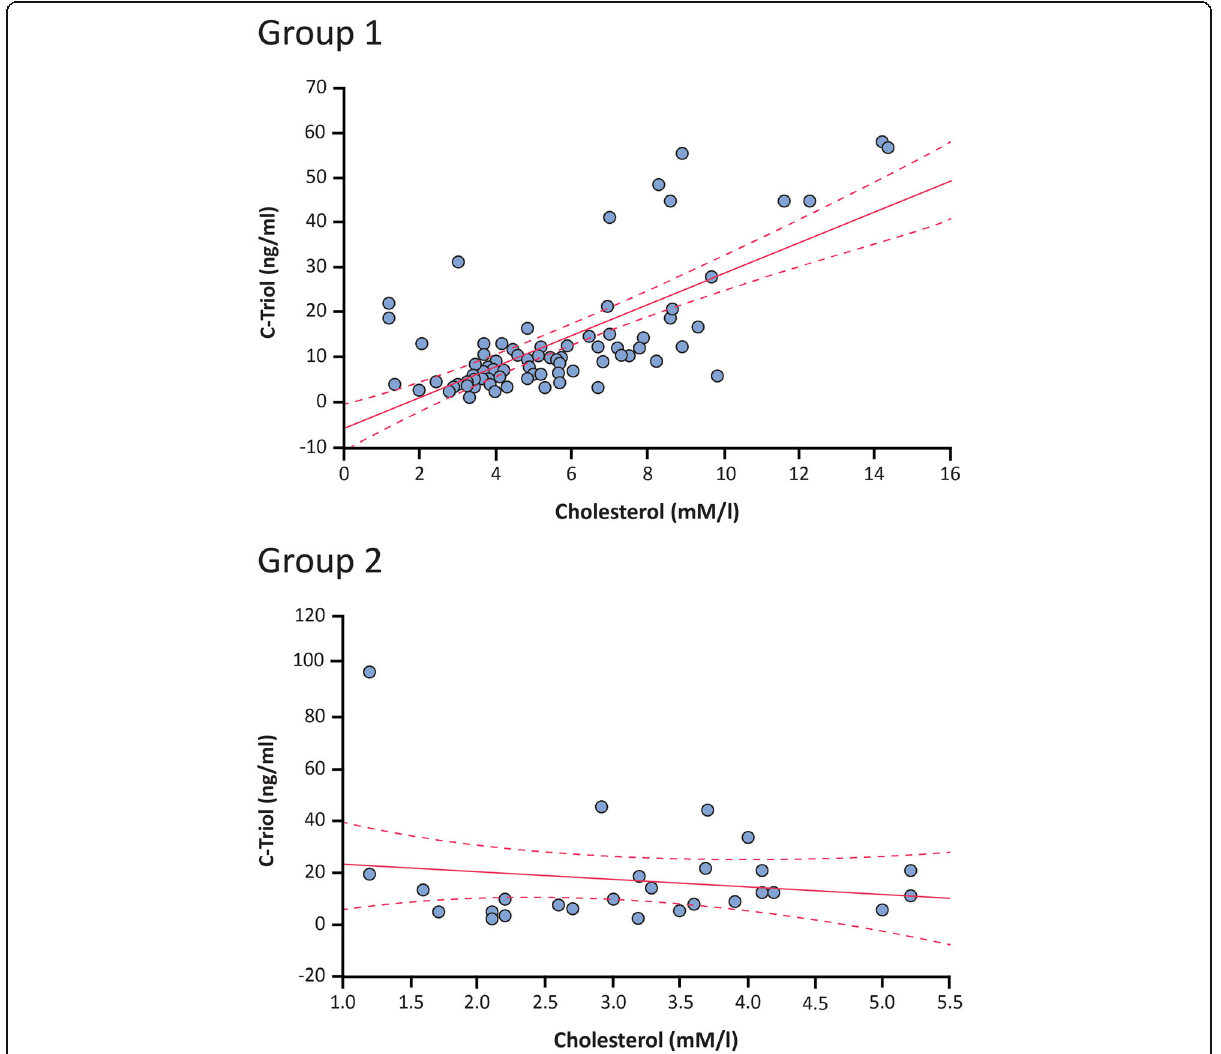
Fig. 2 Correlation analysis between C-triol and blood cholesterol levels. Footnote: The solid red lines are the least-squares regression lines; the dotted red lines represent the 95% confidence